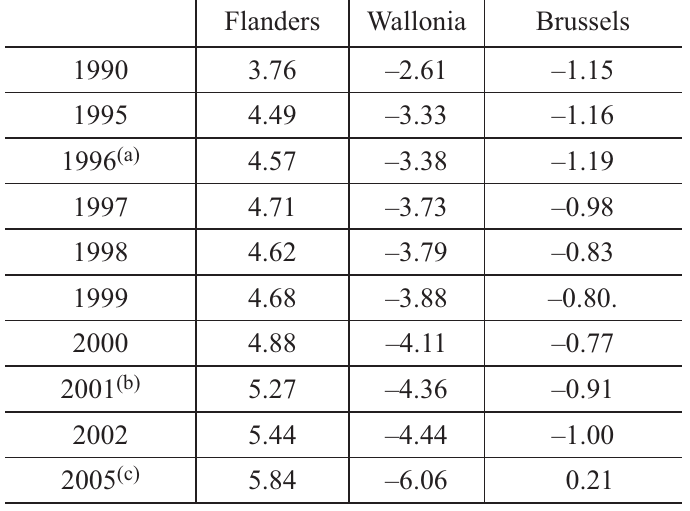
Table 1. Total transfer payments in Public Finance (in billion €) Flanders Wallonia